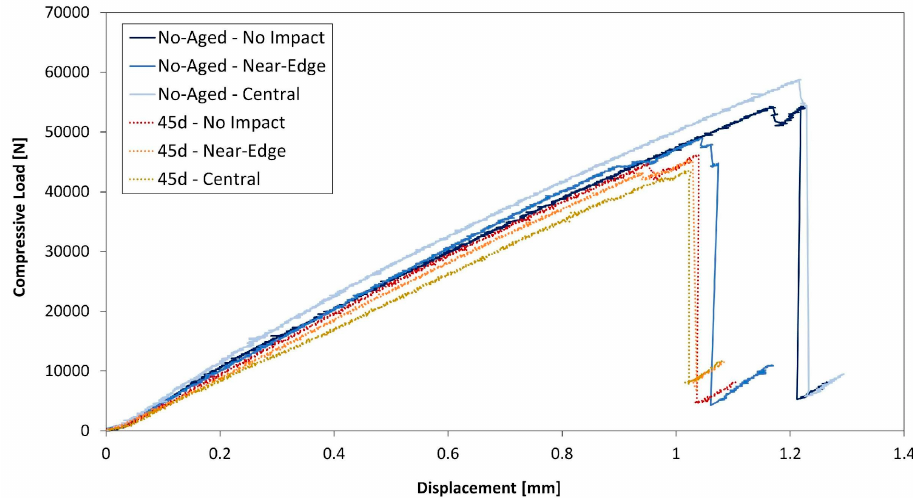
Figure 8. Load-displacement curves. Unaged (solid line) and 45 day-aged (dotted lines) specimens, for all impact locations.